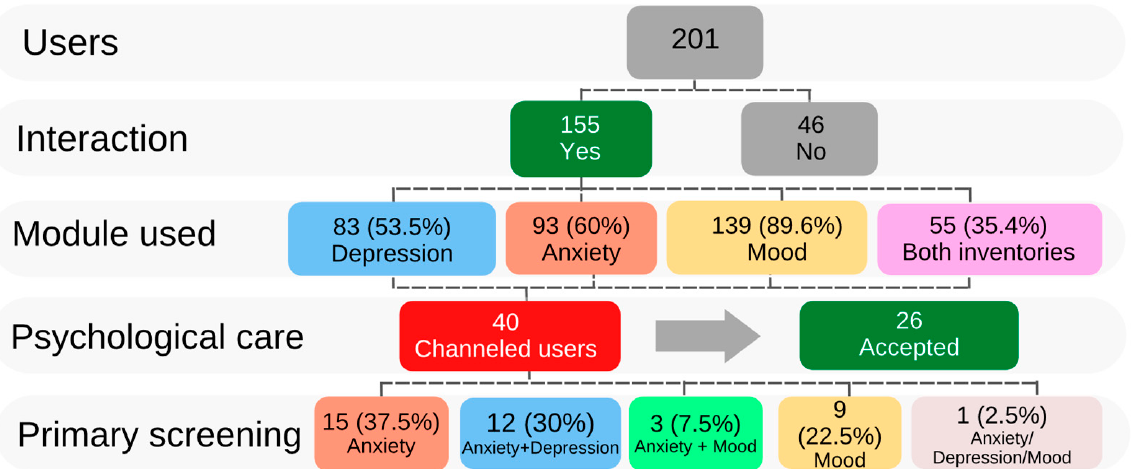
Figure 1. Summary of study population and results of the primary screening approach using Mentali mobile application. There were 201 participants who downloaded and installed the Mentali app; 46 of them were eliminated from the study because they did not interact with Mentali and therefore the final number of users considered for the study was 155. The diagram displays interactions of the users with each Mentali module (anxiety and depression inventories and mood), the number of users who needed psychological intervention, and the results of the primary screening.